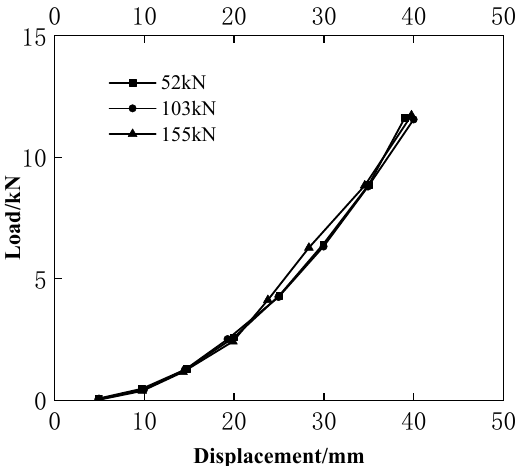
Figure 15. Cumulative energy dissipation curve under different prestress sizes. Compared with the friction energy dissipation curves of PSCFST piers under different prestress sizes (as shows in Figure 16), it can be obtained that with the increase in prestress, the friction energy dissipation of the piers has increased significantly, indicating that the increase in prestress will improve the integrity of piers and increase the friction between segmental joints, so that piers can dissipate more energy under the same displacement conditions.